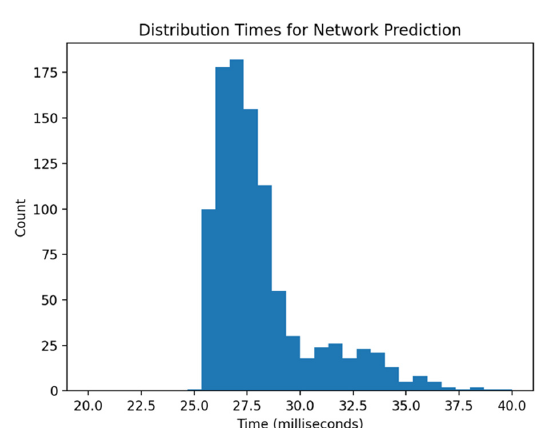
Figure 5. Histogram of model inference times. Most predictions happen in the 25-millisecond to 30-millisecond range, allowing for consistent model use at around 30 Hz.